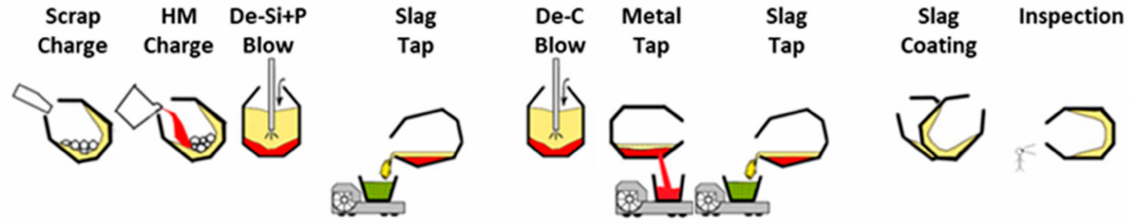
Figure 12. Double slag practice in a single vessel (double-blow-stir).